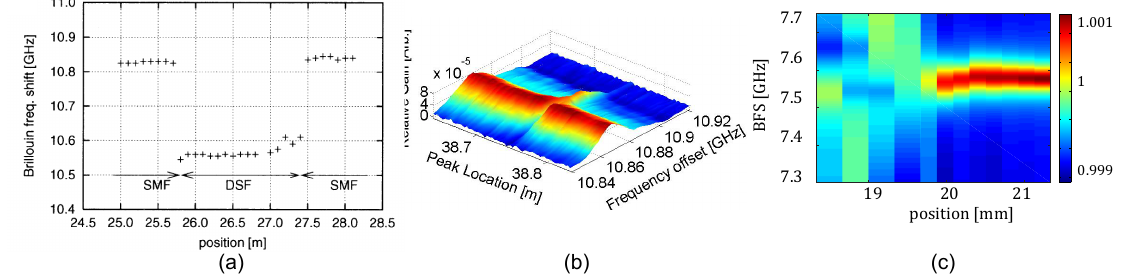
Figure 4. BOCDA techniques based on ( a ) frequency modulation [43] (reprinted with